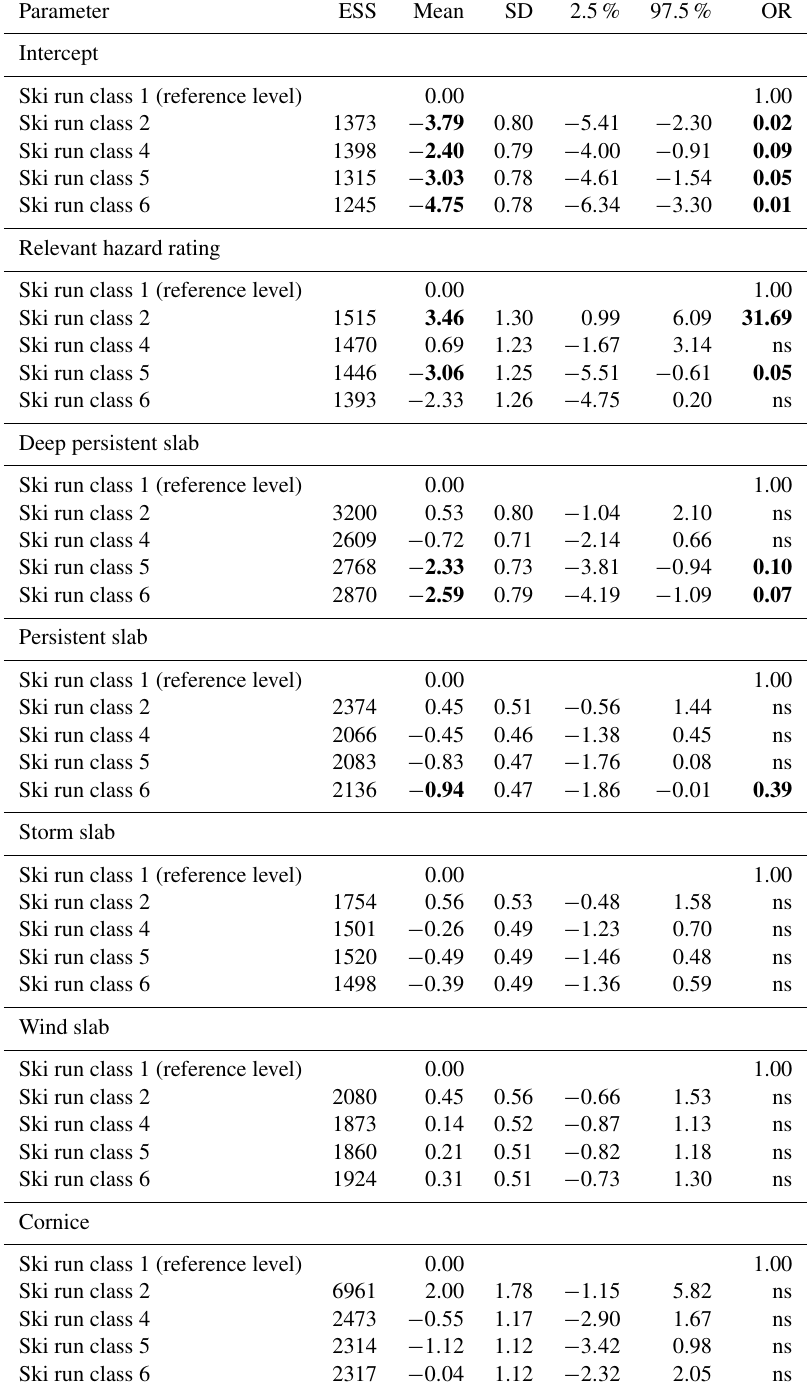
Table 3. Interaction effects. Diagnostics and posterior summary statistics of the estimated parameters from the mixed-effect logistic regres- sion model. ESS is the effective sample size for each parameter. Significant parameter estimates and odds ratios (OR) indicated in bold. Non-significant (ns) ORs are